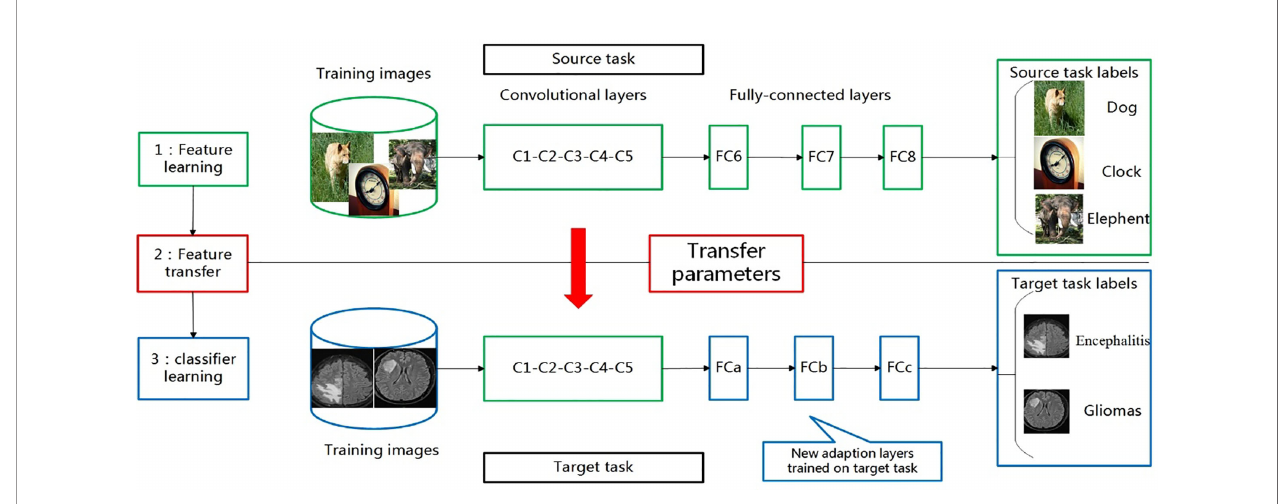
FIGURE 1 | Transferring parameters of convolutional neural network (CNN). First, network is trained on source task (ImageNet classi fi cation, top row) with large amount of available labeled images. Then, convolutional layers (C1-C5) are transferred to target task(brain tumour and encephalitis classi fi cation, bottom row). We remove original fully connected layers (FC6-FC8) and add adaptation layer (FCa-FCc). Last, we fi ne-tune new model on labeled data of target